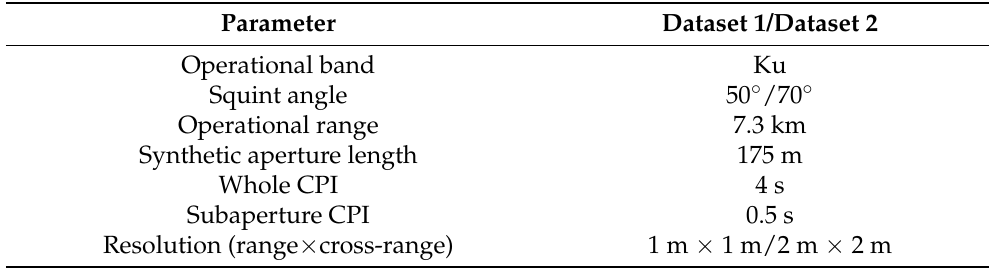
Table 4. Real data parameters.